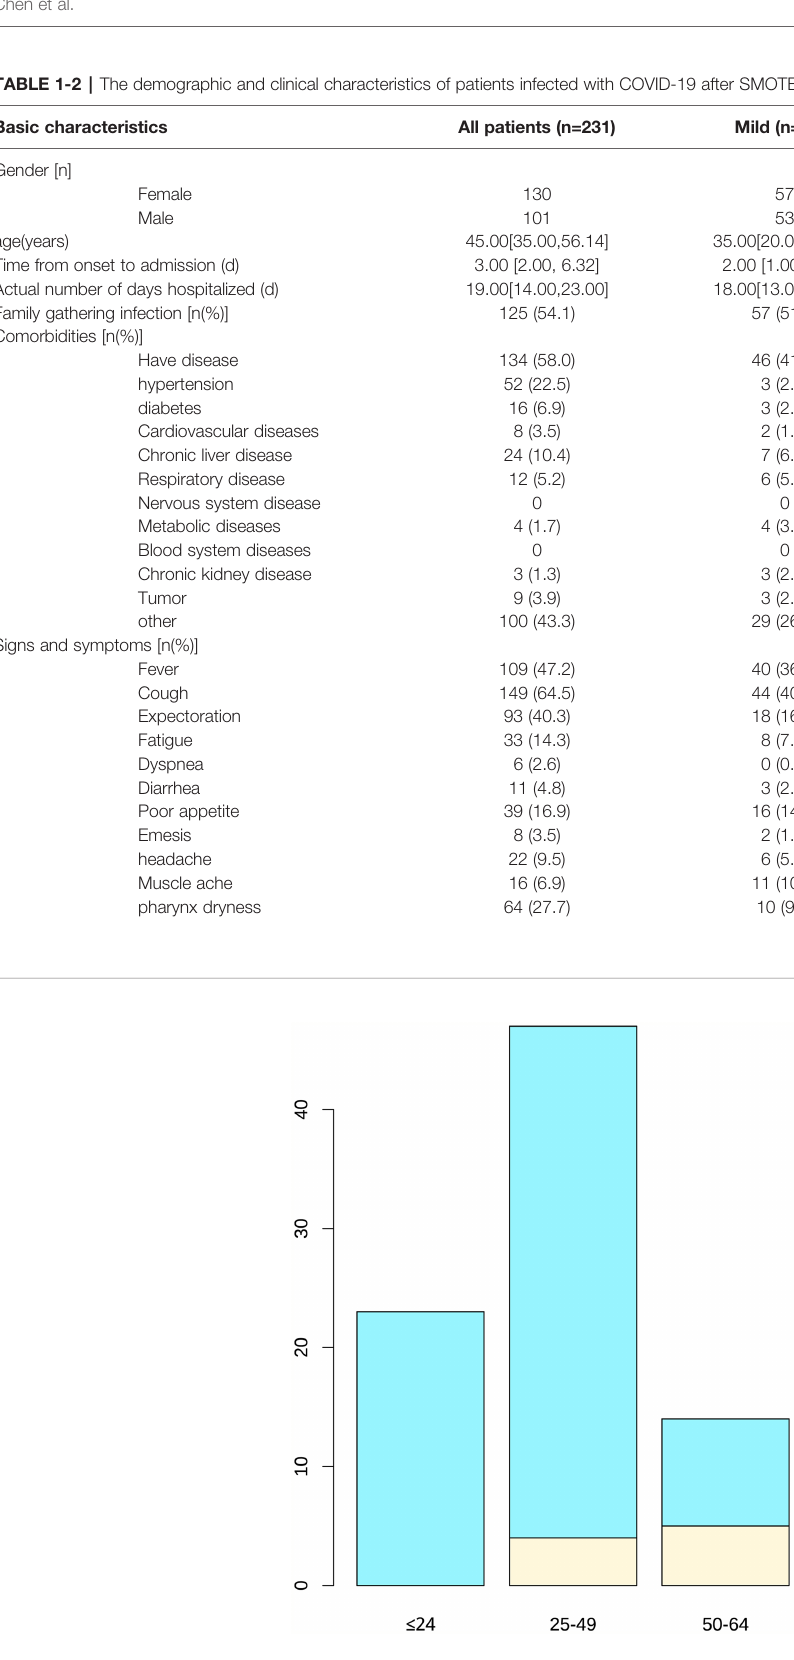
FIGURE 1 | Age distribution of